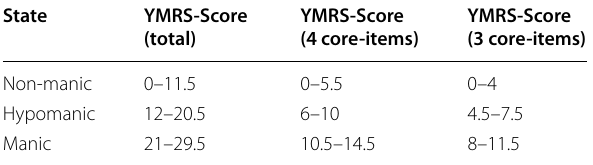
Table 1 Definition of manic, hypomanic and non-manic state by sum scores of all YMRS-items, 4 core YMRS-items and 3 core YMRS-items YMRS-items and core